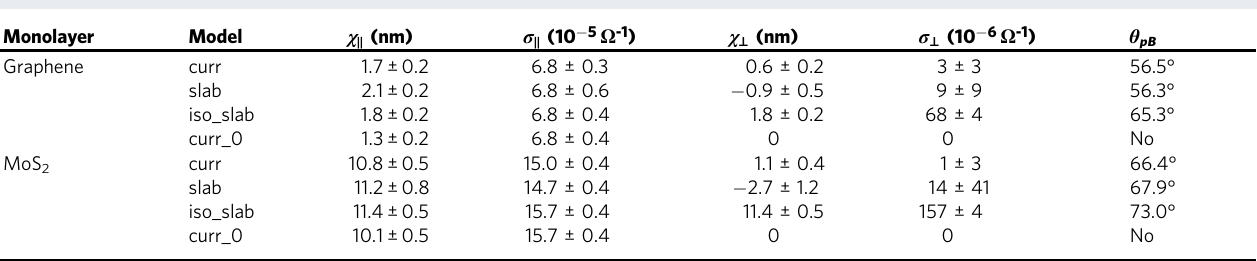
Fig. 3 Experimental results for monolayer MoS 2 immersed in polydimethylsiloxane. Black dots: experimental data, colored dots: extracted optical constants, lines: theoretical fi ts for the four models considered in this paper. a , b Ellipsometric parameters Ψ i and Δ i . Neither the iso_slab model nor the curr_0 model fi ts the data, using as optical constants those extracted from the Ψ s and Δ s . c , d Optical constants determined with slab and the curr model. They predict similar χ ∥ and σ ∥ , but negative and positive χ ⊥ respectively, and σ ⊥ compatible with 0 Ω − 1 . The error bars reported are the standard deviation of these values (see Table 1). e Re fl ectivities for s and p polarized light. Experimental data show a pseudo Brewster angle for R ip . The iso_slab model fails to predict its position by almost 7°. The curr_0 model does not predict it at all. All models fi t R is reasonably well (for clarity we show only the curr model and the slab model). Table 1 Optical constants for monolayer graphene and MoS 2